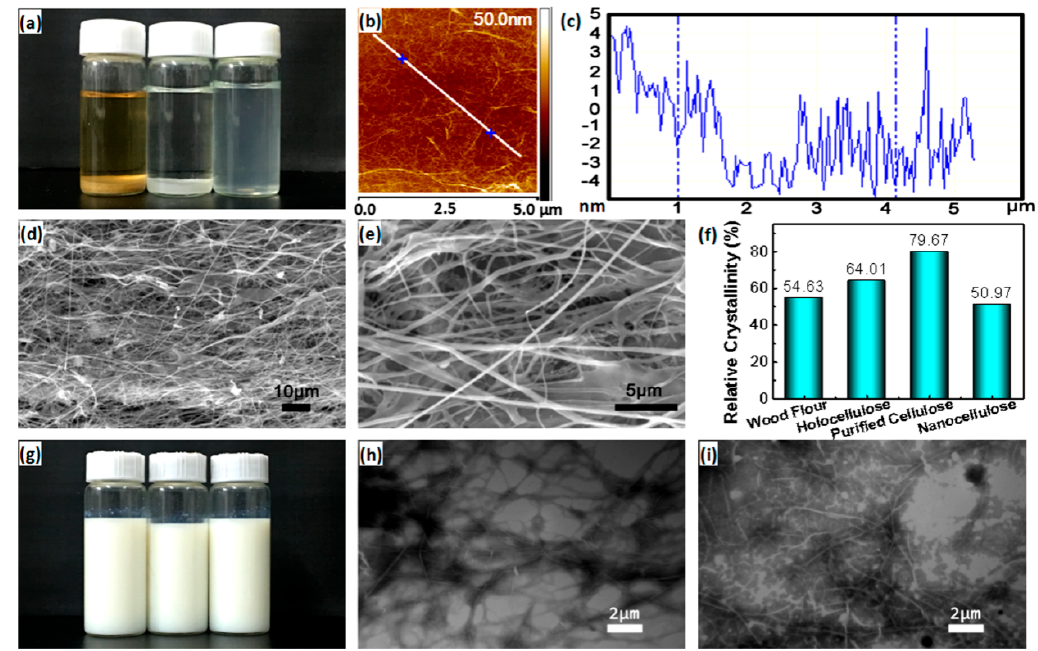
Figure 2. Nanocellulose morphology and structural characterization. ( a ) Photograph of the evolution of raw material morphology during the preparation of nanocellulose, from left to right: raw wood flour, purified cellulose and nanocellulose in water; ( b ) Atomic force microscopy (AFM) characterization of nanocellulose; ( c ) Diameter distribution of nanocellulose corresponding to the ( b ); ( d ) Scanning electron microscopy (SEM) photograph of nanocellulose; ( e ) An enlarged SEM photograph of ( d ); ( f ) Relative crystallinity change during the preparation of nanocellulose; ( g ) Photograph of different waterborne polyurethane (PU) emulsions (left, control PU emulsion; the middle one contains 0.1 wt% of nanocellulose by physical addition; the right one contains 0.1 wt% of nanocellulose by chemical addition); ( h ) Transmission electron microscopy (TEM) photograph of waterborne polyurethane emulsion with 0.1 wt% nanocellulose addition by physical blending way; ( i ) TEM photograph of waterborne polyurethane emulsion with 0.1 wt% nanocellulose addition by chemical modification way.